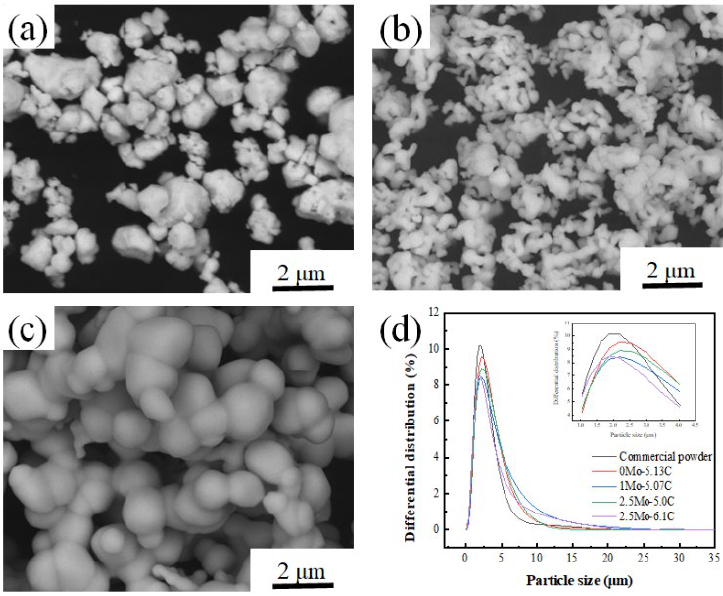
Figure 1. SEM of ( a ) WC powders, ( b ) Co powders, ( c ) Mo powders, ( d ) Size distribution of commercial WC and ball-milled powders. Table 1. The nominal chemical compositions of WC-13Co cemented carbides (wt.%).